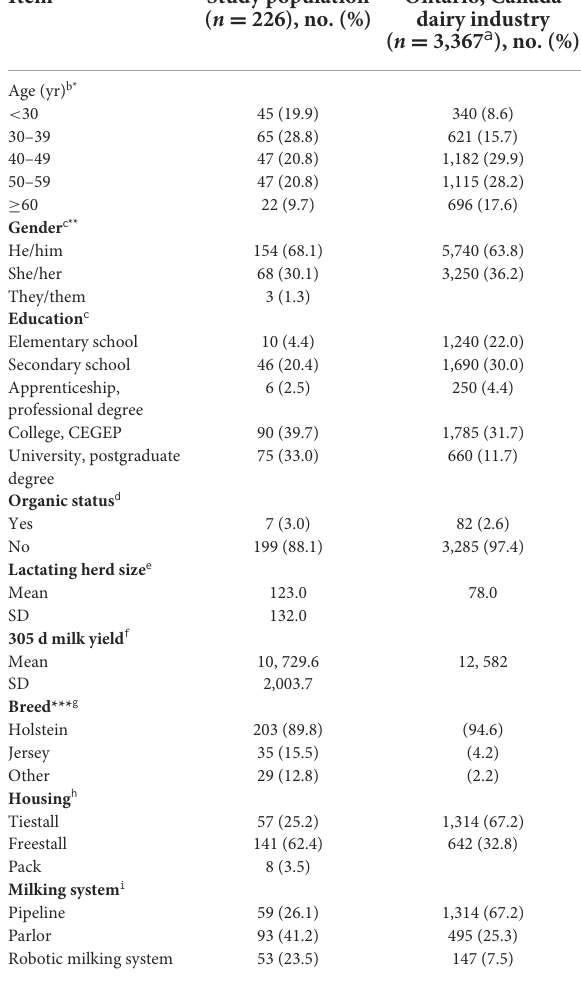
TABLE 1 Comparison of survey respondents in the study to the overall Ontario, Canada dairy industry (complied from a variety of sources) by personnel and farm-level demographic